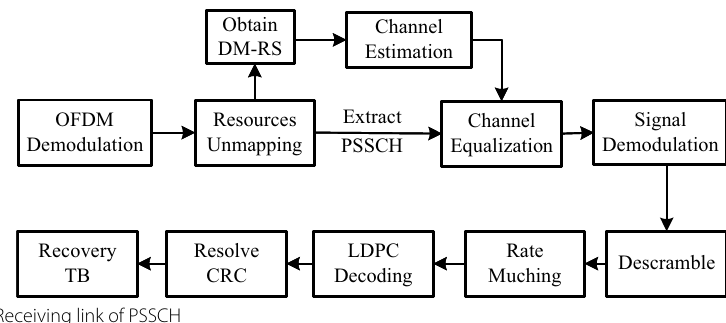
Fig. 3 Receiving link of